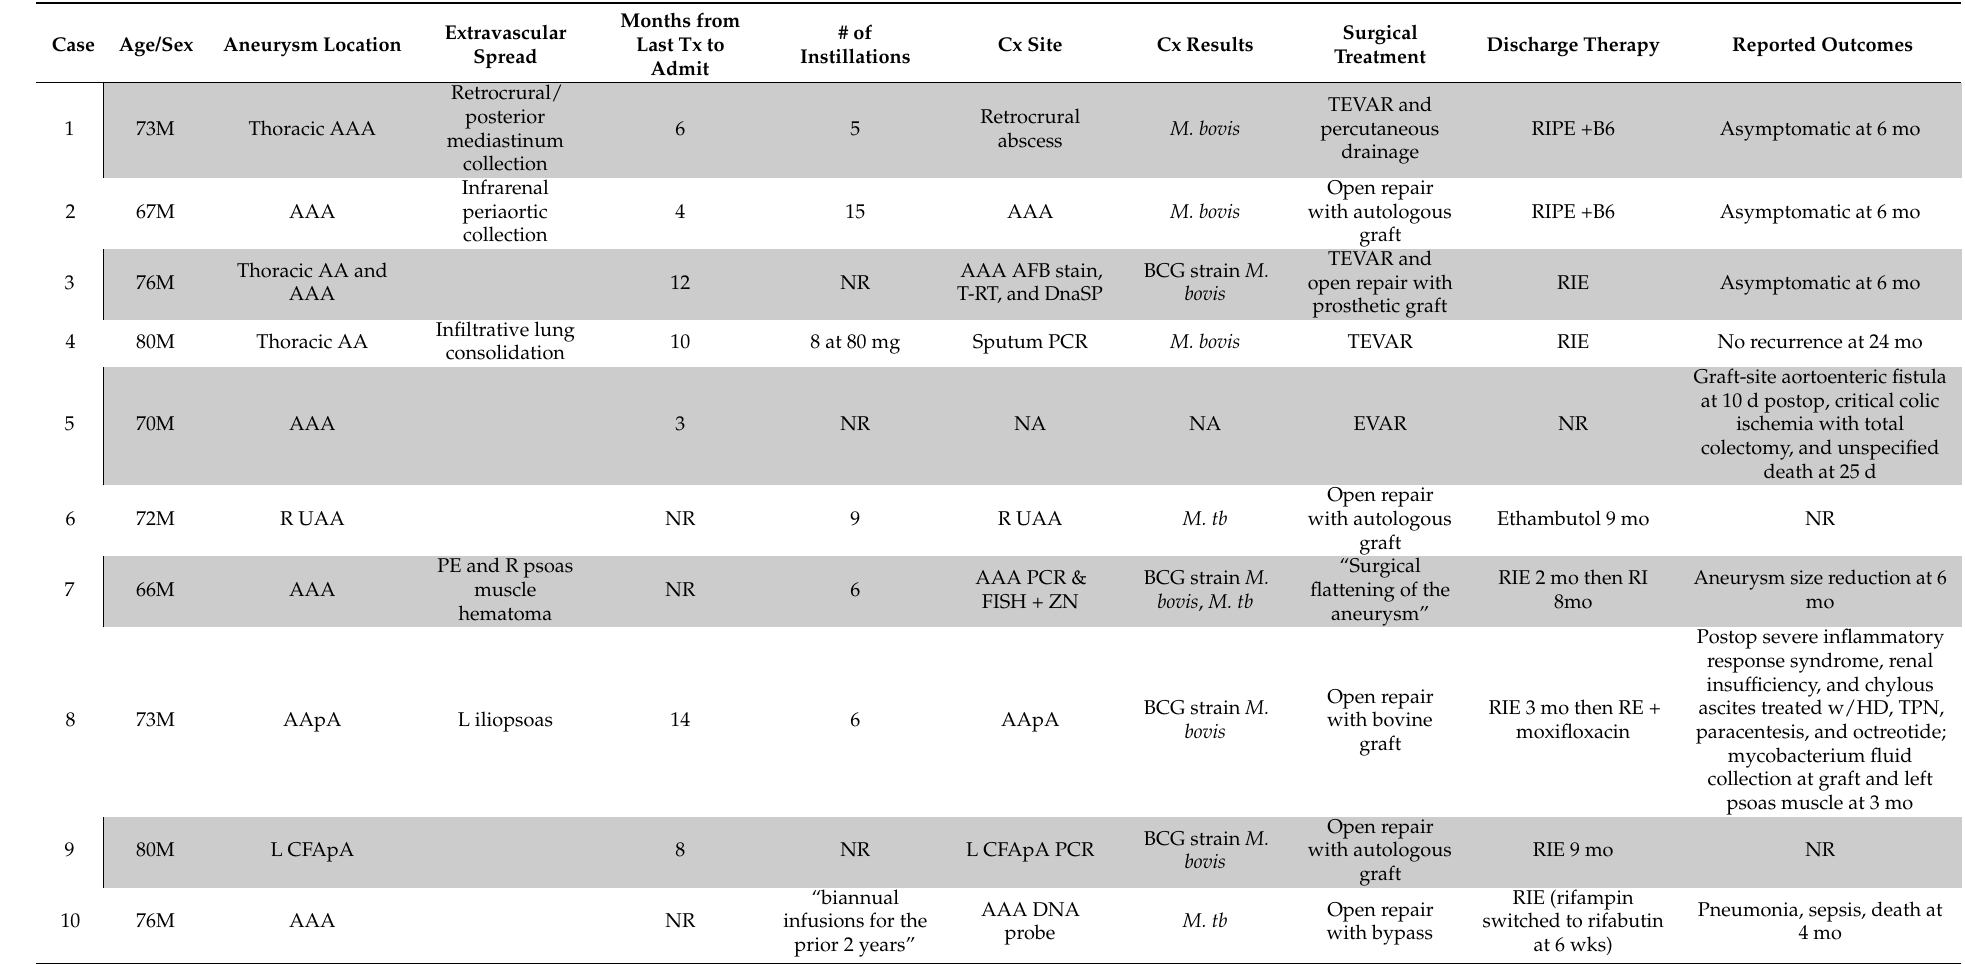
Table 1. Summary of results from featured case reports of suspected BCG intravesical therapy induced